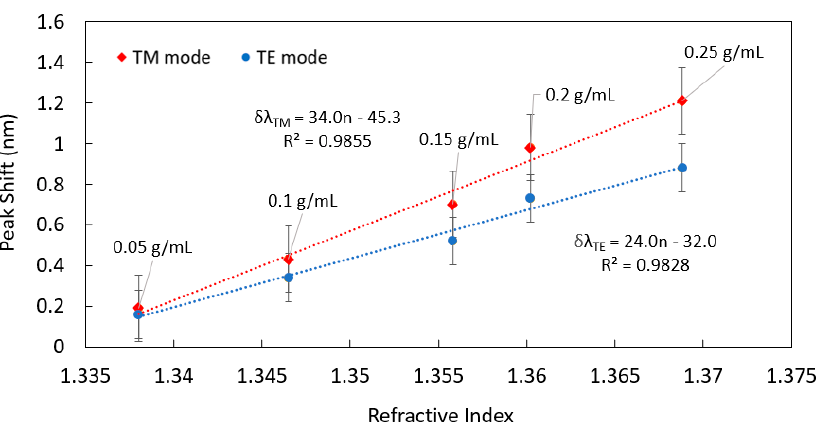
Figure 4. Wavelength shift of TE and TM WGMs within a longer microfluidic chip, as a function of glucose concentration. In this result progressively higher concentrations of glucose are added to the chip reservoir rather than allowing the liquid to first evaporate. In this case, a single chip and microsphere was used for all measurements.